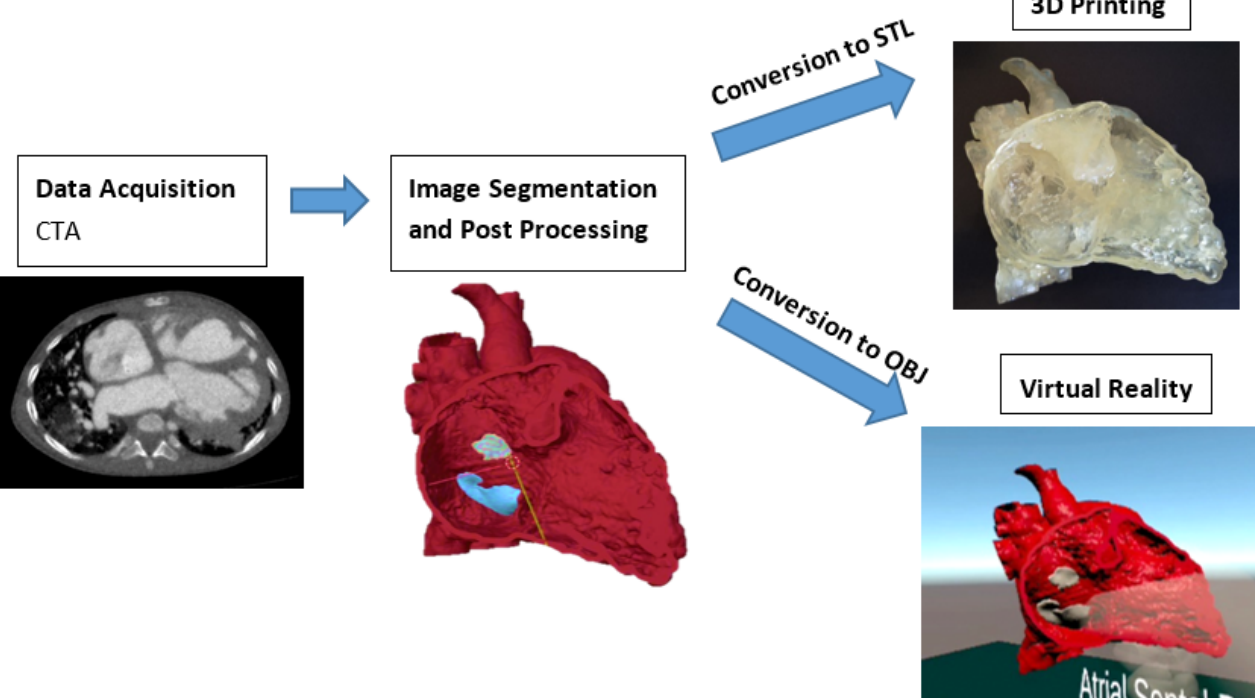
Figure 3. Steps involved in the creation of 3DPHM and the VR project. 3D, three-dimensional; CTA, computed tomography angiography; OBJ, object files; STL, standard tessellation language.